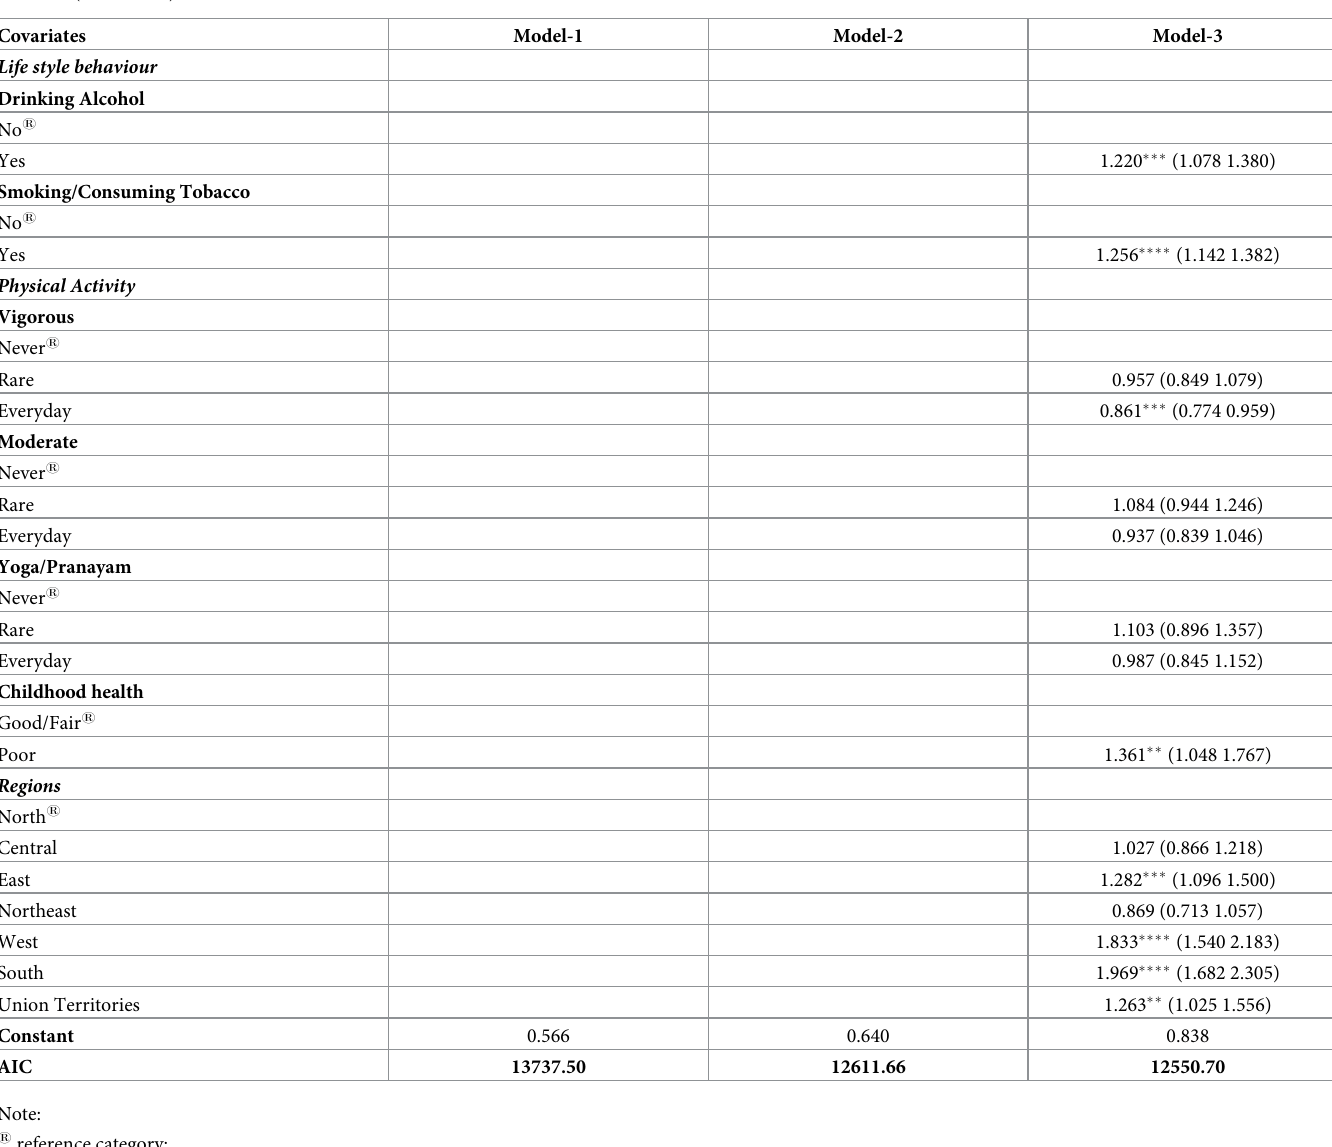
PCF (adjusted for CHC residual) are 1.7 folds among informal workers (OR = 1.683, 95%CI: 1.514–1.870, p < 0.0001; compared to formal). In Model-3, the odds of PCF are 1.155 times for informal workers without CHC residual (CHC residual = 0) as compared formal workers without CHC residual (OR = 1.155, 95%CI: 1.152–1.637, p < 0.05) after controlling for covariates. However, CHC residual loses its signifi- cance level after adding the interaction term and controlling socio-economic and demographic variables in model-2, and work-characteristics, life-style behavior, and childhood health